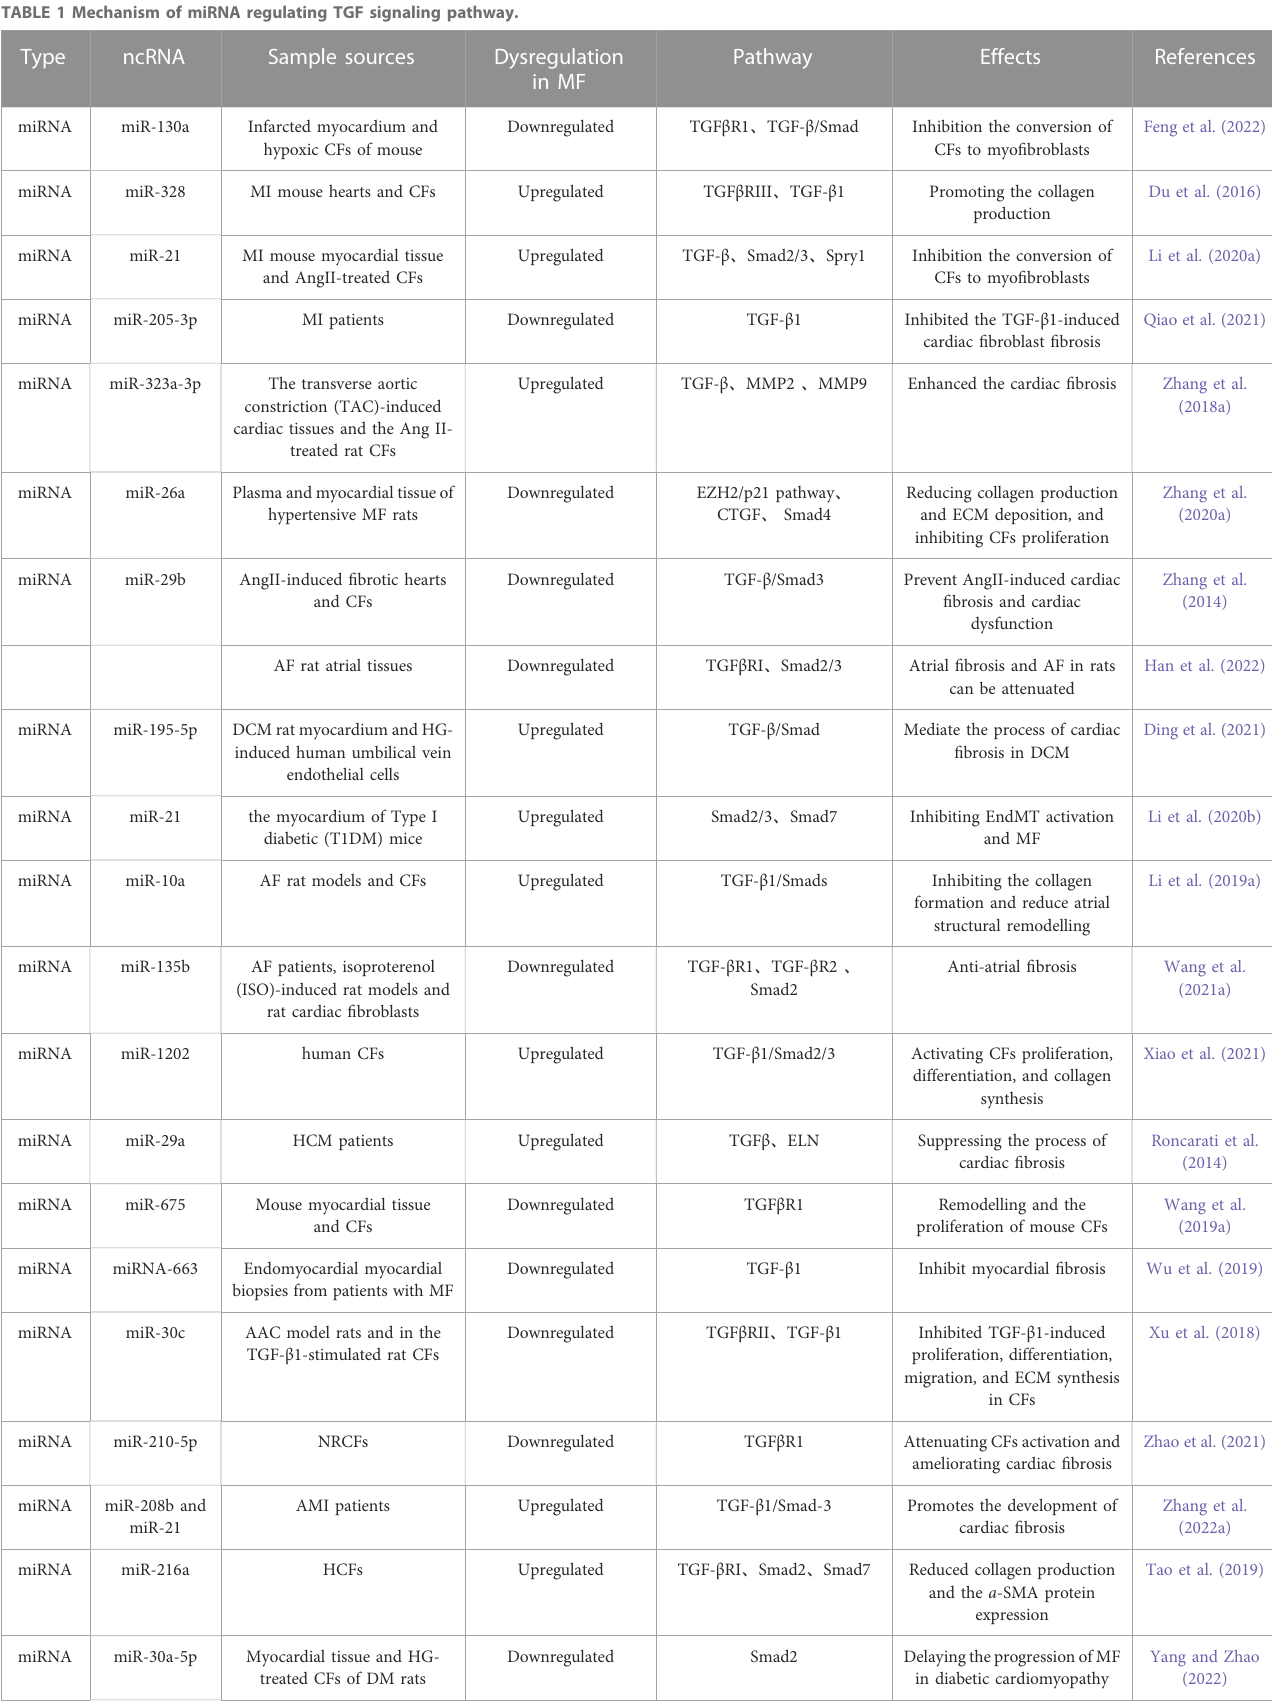
TABLE 1 Mechanism of miRNA regulating TGF signaling